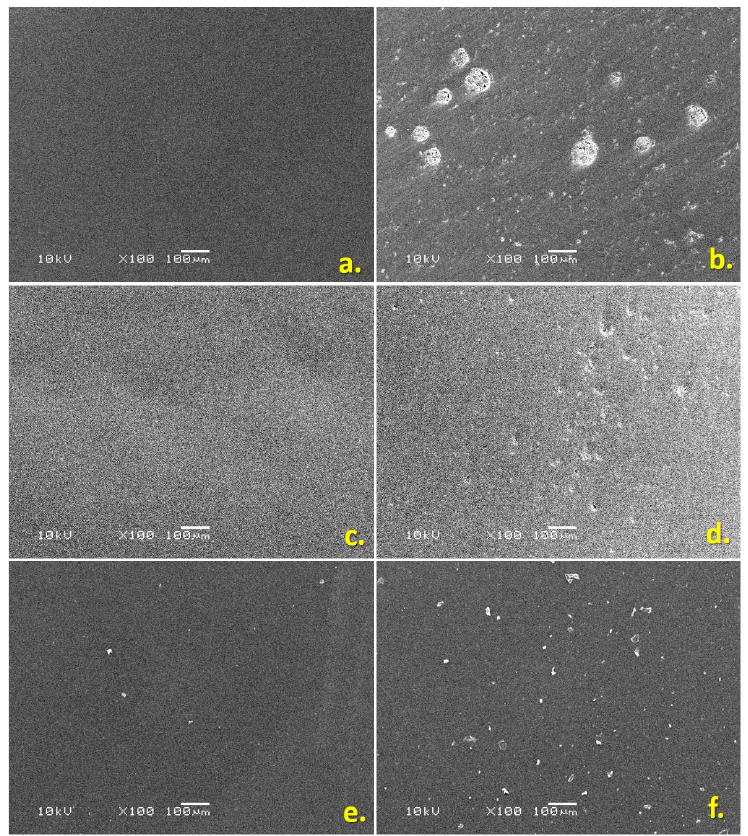
Figure 2. Scanning electron microscopic (SEM) images of the three tested materials before and after the surface bleaching. ( a ) IPS e.max image before the bleaching; ( b ) IPS e.max image after the bleaching; ( c ) LZr image before the bleaching; ( d ) LZr image after the bleaching; ( e ) TZr image before the bleaching; ( f ) TZR image after the bleaching.